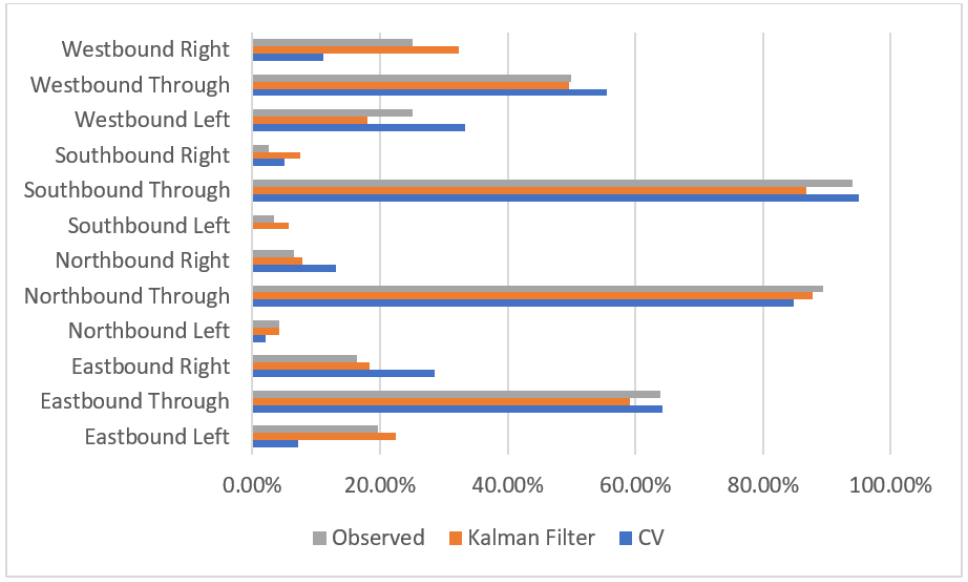
Figure 12. Comparison of CV, KF, and Observed TM Percentages for 7:30 – 9:30 a.m. 21 January 2021.